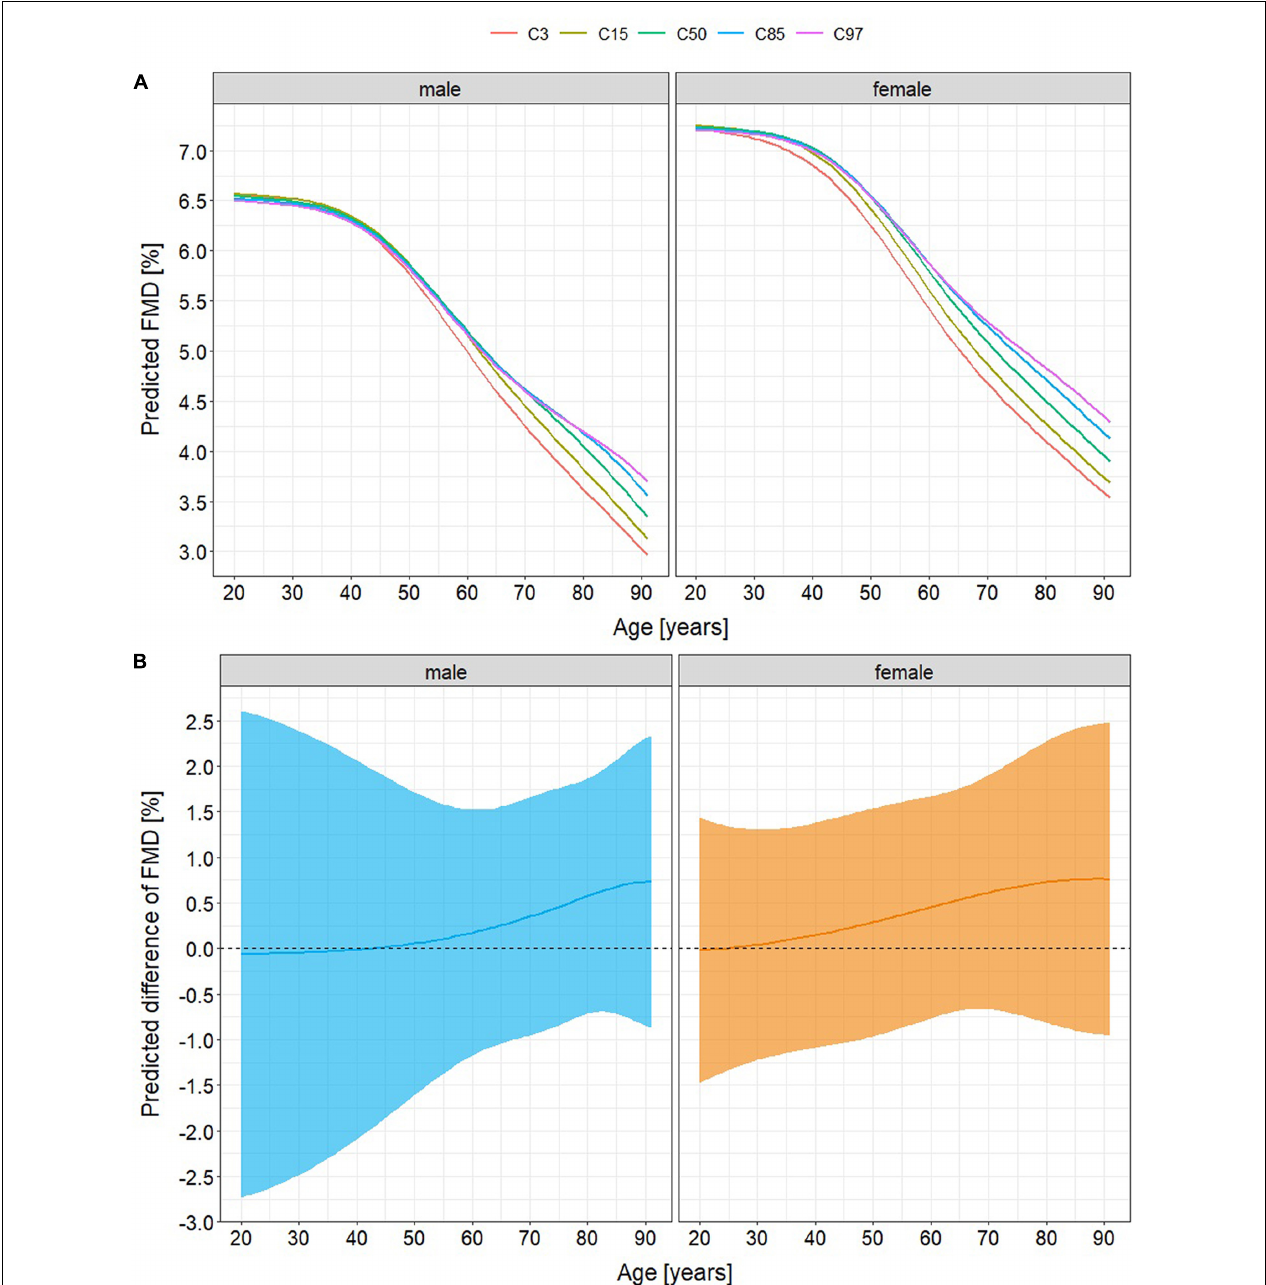
FIGURE 3 | Age-related differences of flow-mediated vasodilation (FMD) in patients with cardiovascular diseases (A) stratified by percentile of peak oxygen consumption (˙VO 2 peak) and (B) predicted difference between FMD in the lowest-fit (˙VO 2 peak ≤ 3rd percentile) and FMD in the highest fit (˙VO 2 peak ≥ 97th percentile) individuals. There are no differences associated with cardiorespiratory fitness until the age of 30 (women) and 50 years (men). Afterward, models predict a lower FMD alt old age of 12% in very low-fit men (maximum age-related difference of 43% if ˙VO 2 peak ≥ 97th percentile versus 55% if ˙VO 2 peak ≤ 3rd percentile) and of 11% in very low-fit women (41% versus 52%). Absolute mean differences of FMD between ˙VO 2 peak percentiles ≤ 3rd versus ≥ 97th deviate from 0 in tendency at middle and old age (maximum 0.75%, 95% confidence intervals –0.8 – 2.3% (men) and –1.0 – 2.5% (women)). C3, 15, 50, 85, and 97 = ˙VO 2 peak percentiles (3rd, 15th, 50th, 85th, and 97th).